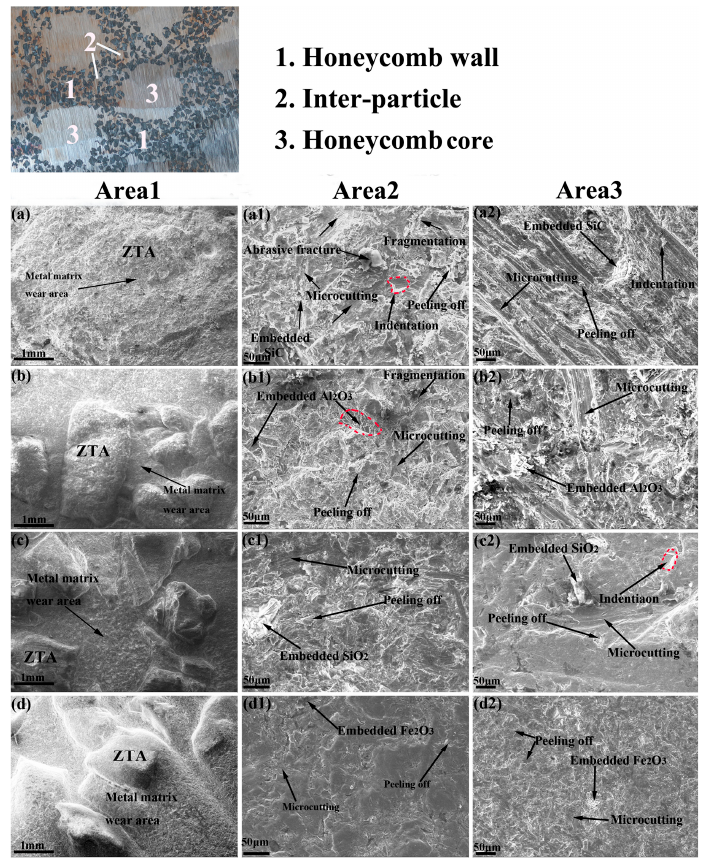
Figure 9. Worn surfaces of different areas of the composites in different abrasive: ( a ) SiC, ( b ) Al 2 O 3 , ( c ) SiO 2 ; ( d ) Fe 2 O 3 .